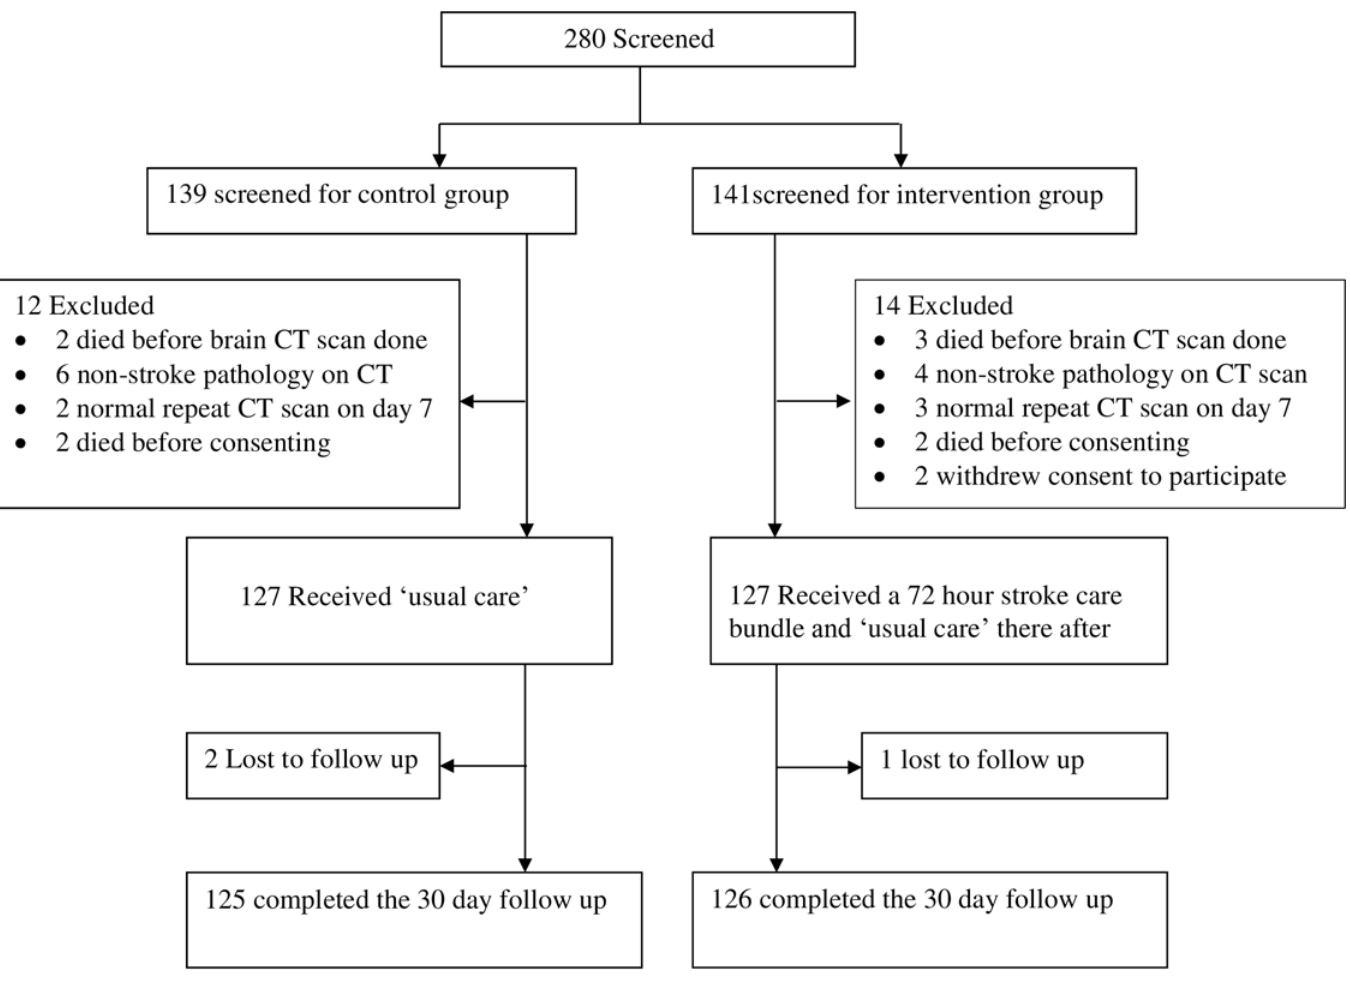
Fig 1. Consort flow